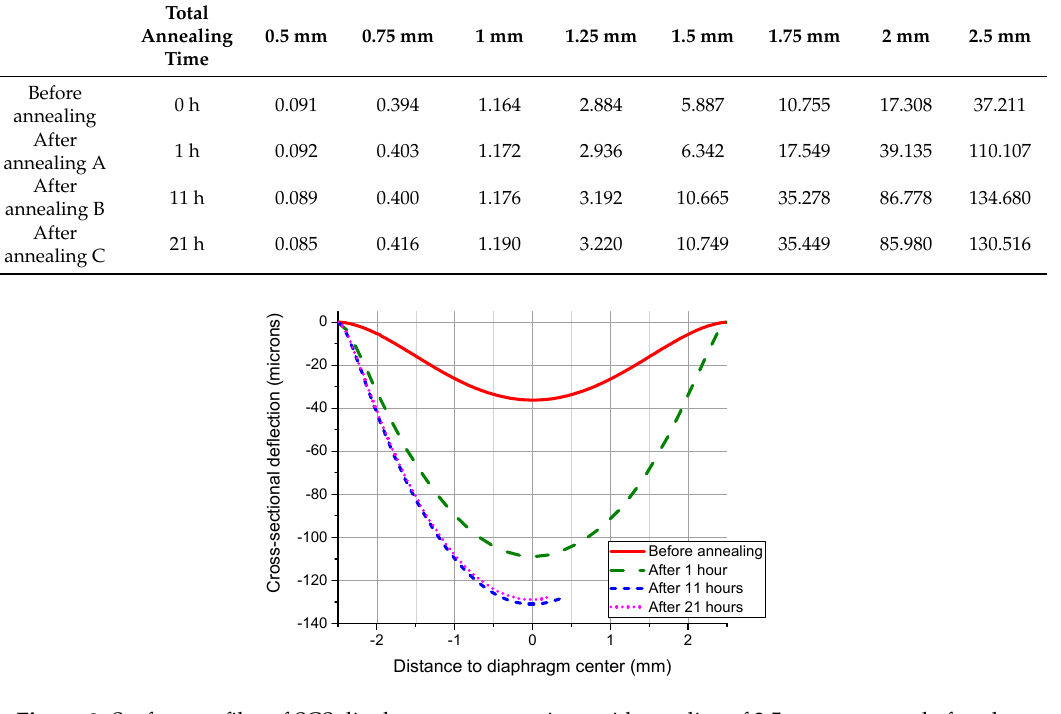
Figure 9. Surface profiles of SCS diaphragm cross-sections with a radius of 2.5 mm measured after the annealing processes at 900 °C.